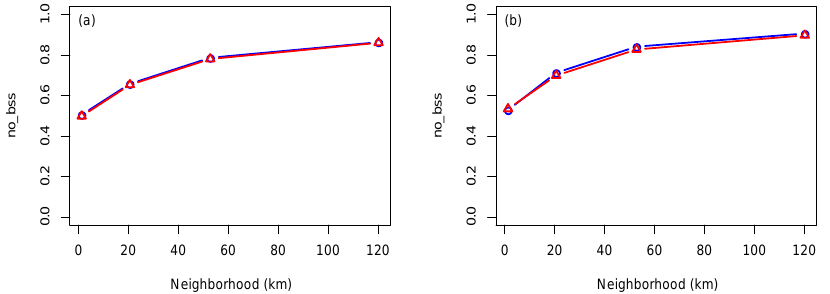
Figure 4. Neighbourhood observation Brier skill score for precipitation between 12:00 and 18:00UTC over the period 1–30 November 2014, for REF (blue circles) and FCI (red triangles): (a) threshold 2mm; (b) threshold